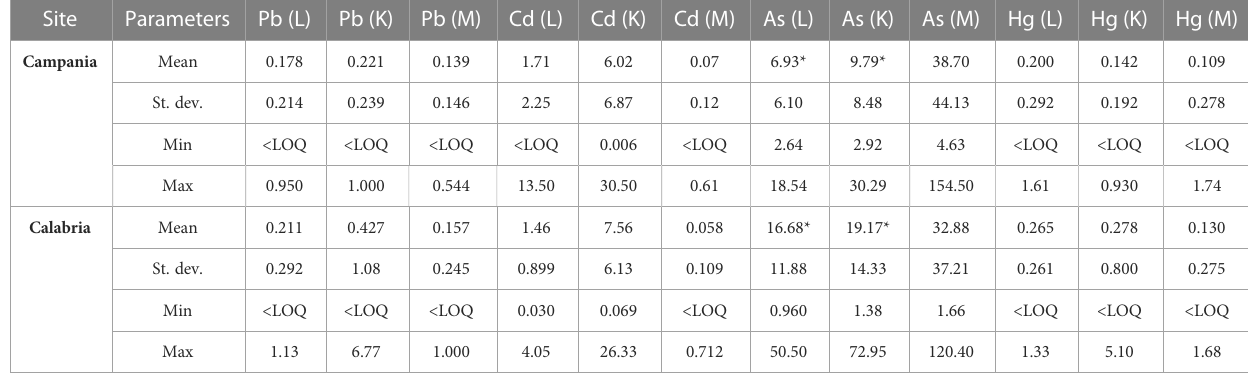
TABLE 5 Range, mean, and standard deviation of As, Cd, Hg, and Pb (mg kg − 1 wet weight) in the liver (L), kidney (K), and muscle (M) of analysed turtles according to the collection site. Site